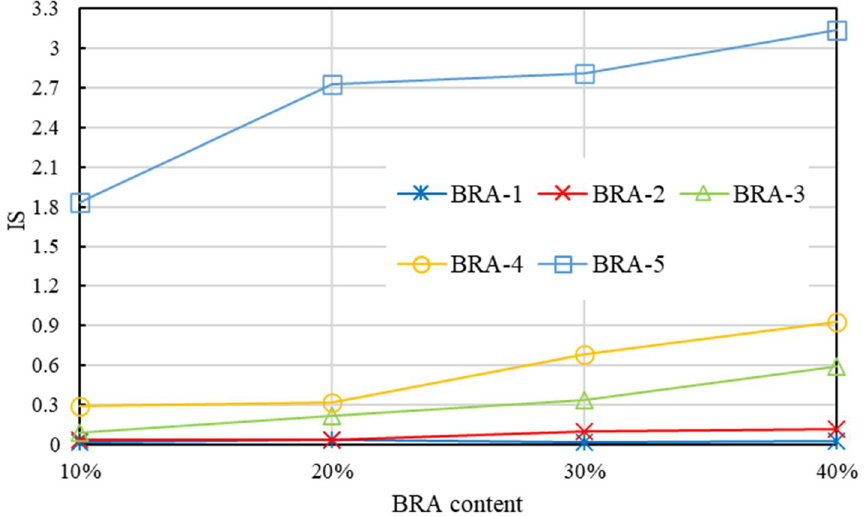
Figure 16. IS of BRA-MA after the segregation